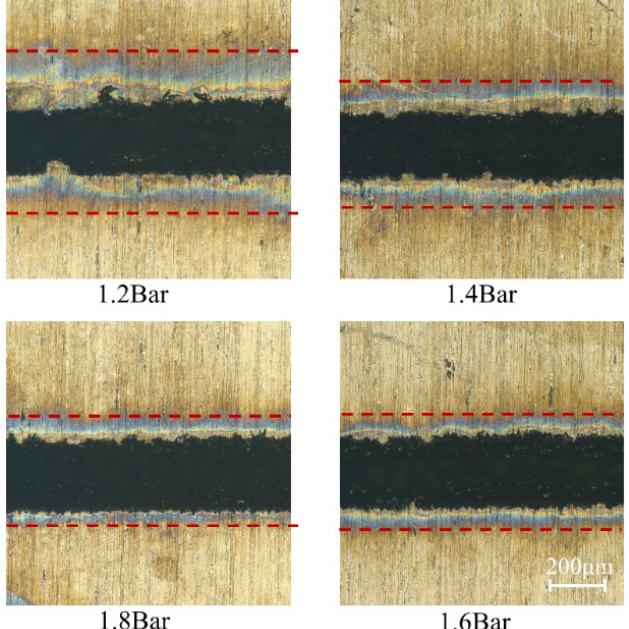
Figure 9. Cutting surface morphology under different water pressures.